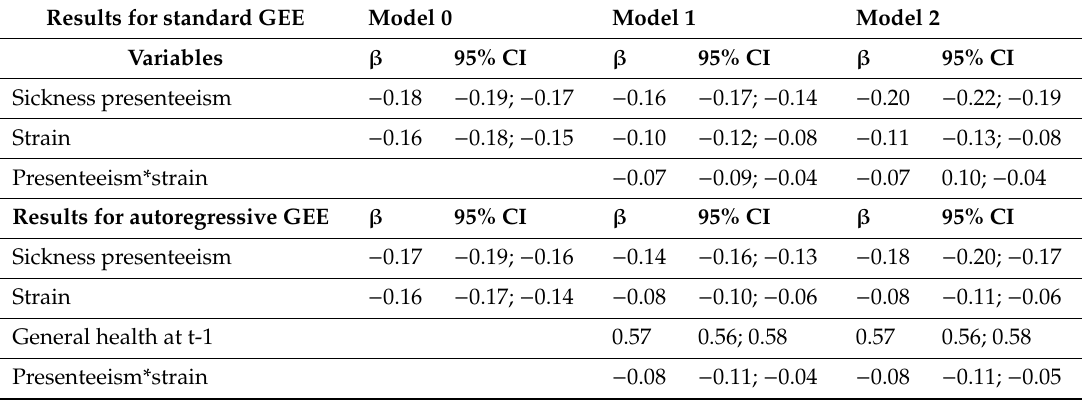
Table 3. Results of standard and autoregressive generalized estimating equation (GEE) analyses of the association between sickness presenteeism (1 = sickness presenteeism of ≥ 1 day during the past 12 months) and general health, presented as beta estimates ( β ) with 95% CIs, taking job strain as a possible moderating job characteristic into account.